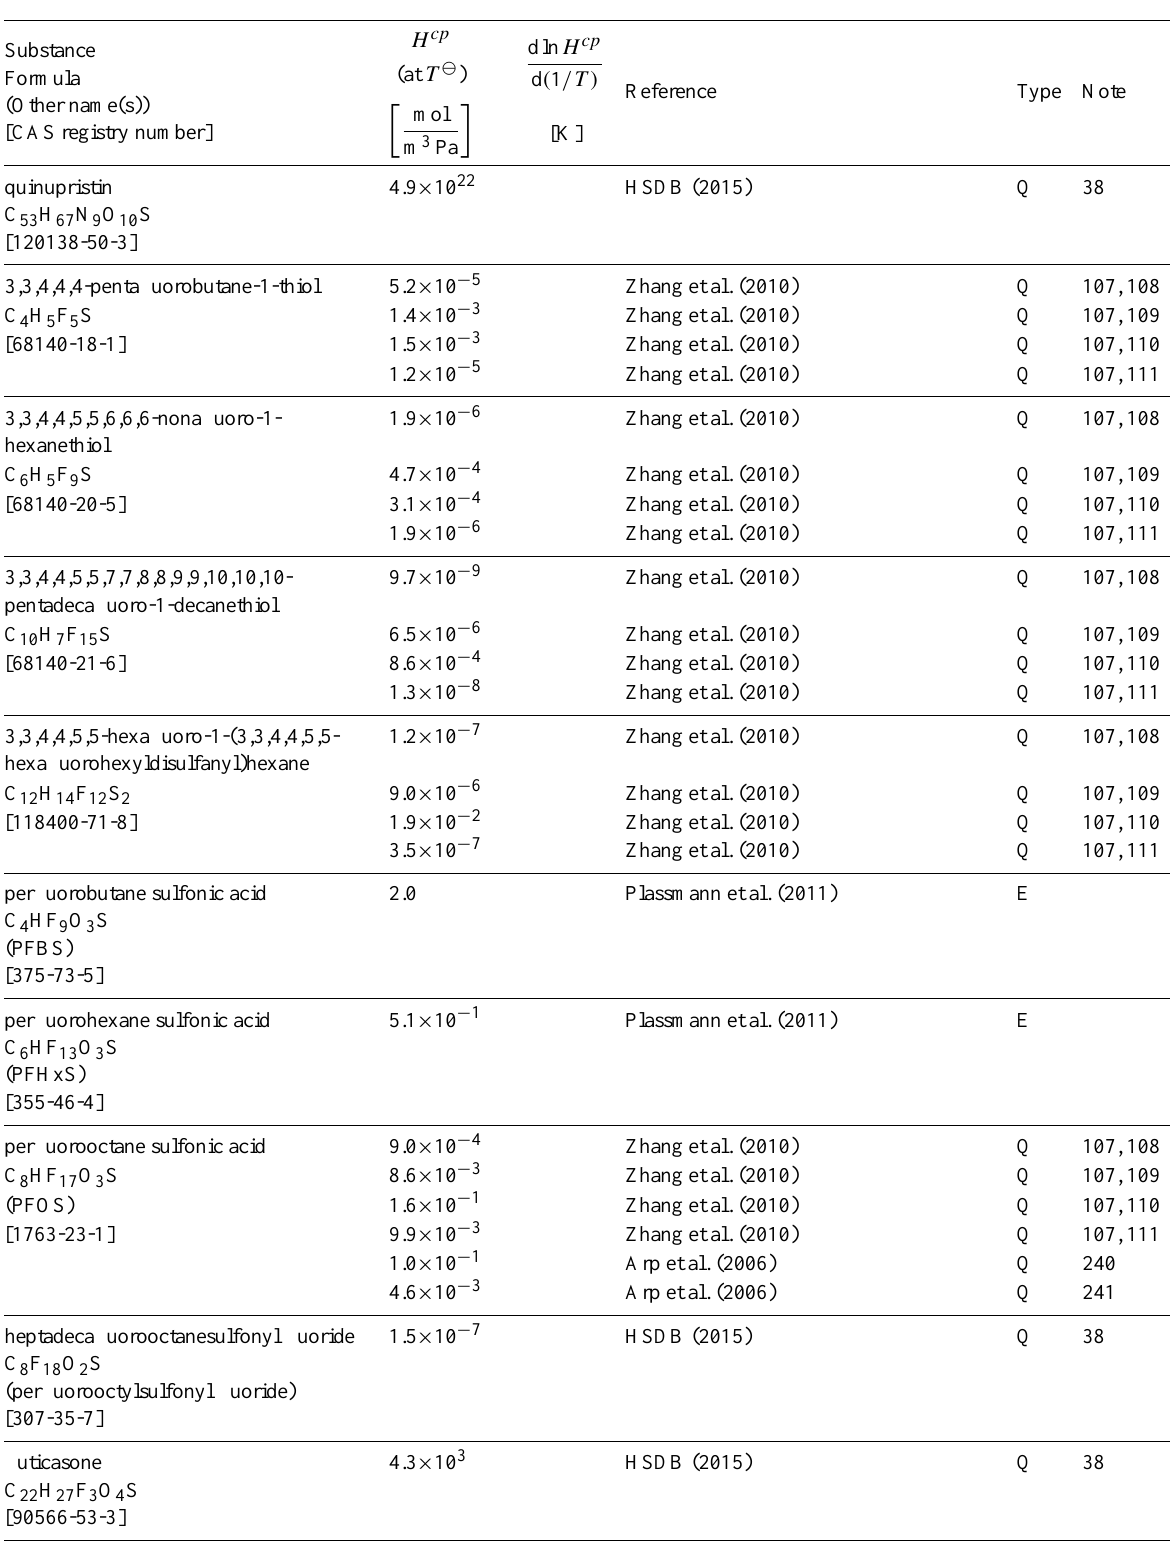
Table 6: Henry’s law constants for water as solvent